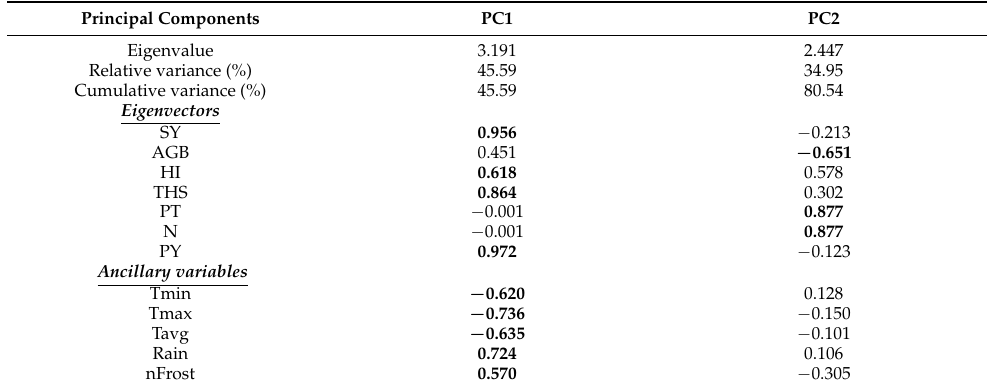
Table 6. Eigenvalues, relative, and cumulative percentage of total variance, and correlation coeffi- cients for faba bean traits with respect to the two principal components (PC1 and PC2).